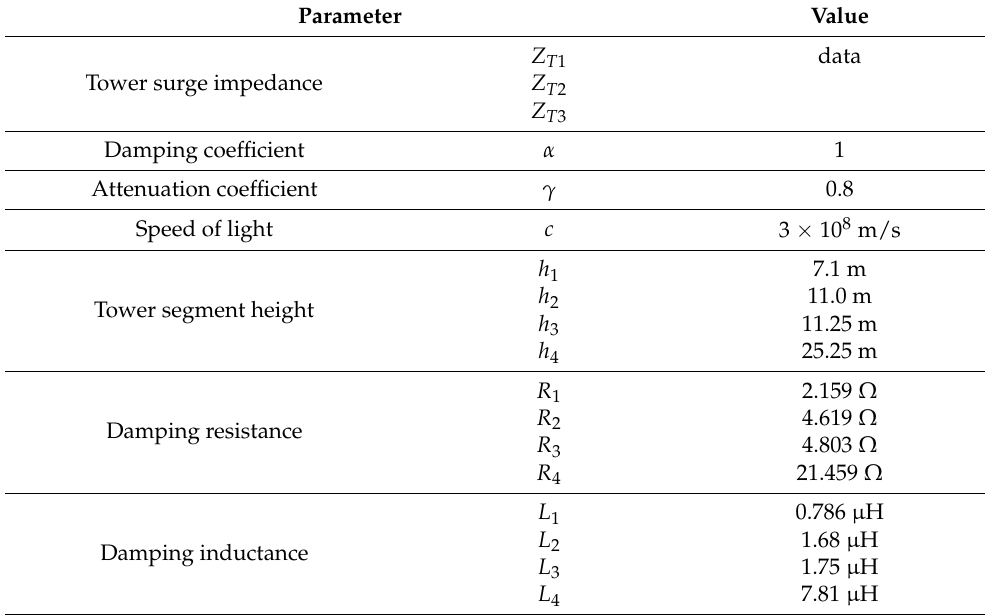
Table 4. Multi-story circuit parameters of the lattice 500 kV tower model. Parameter Value Z T 1 Tower surge impedance